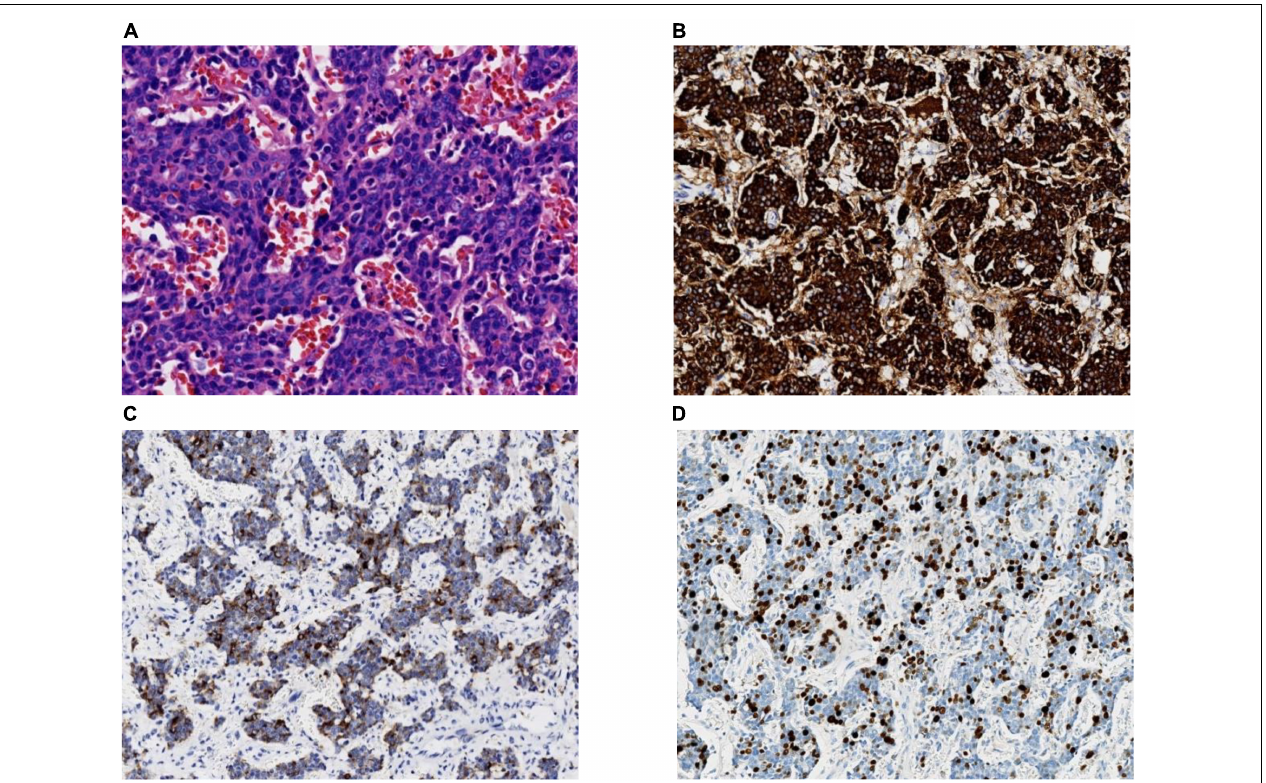
FIGURE 4 | (A) A high-power view of the tumour biopsy under a light microscope. Hematoxylin and eosin staining (magnification, 40 × ); (B) synaptophysin staining (magnification, 20 × ); (C) chromogranin A staining (magnification, 20 × ); (D) Ki-67 staining. In total, ∼ 30% of the tumour cells are positive (magnification, 20 ×